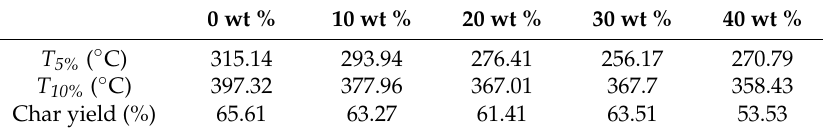
Figure 6. Thermal properties of the various composite laminates. Table 2. Thermal properties of the various composite laminates.